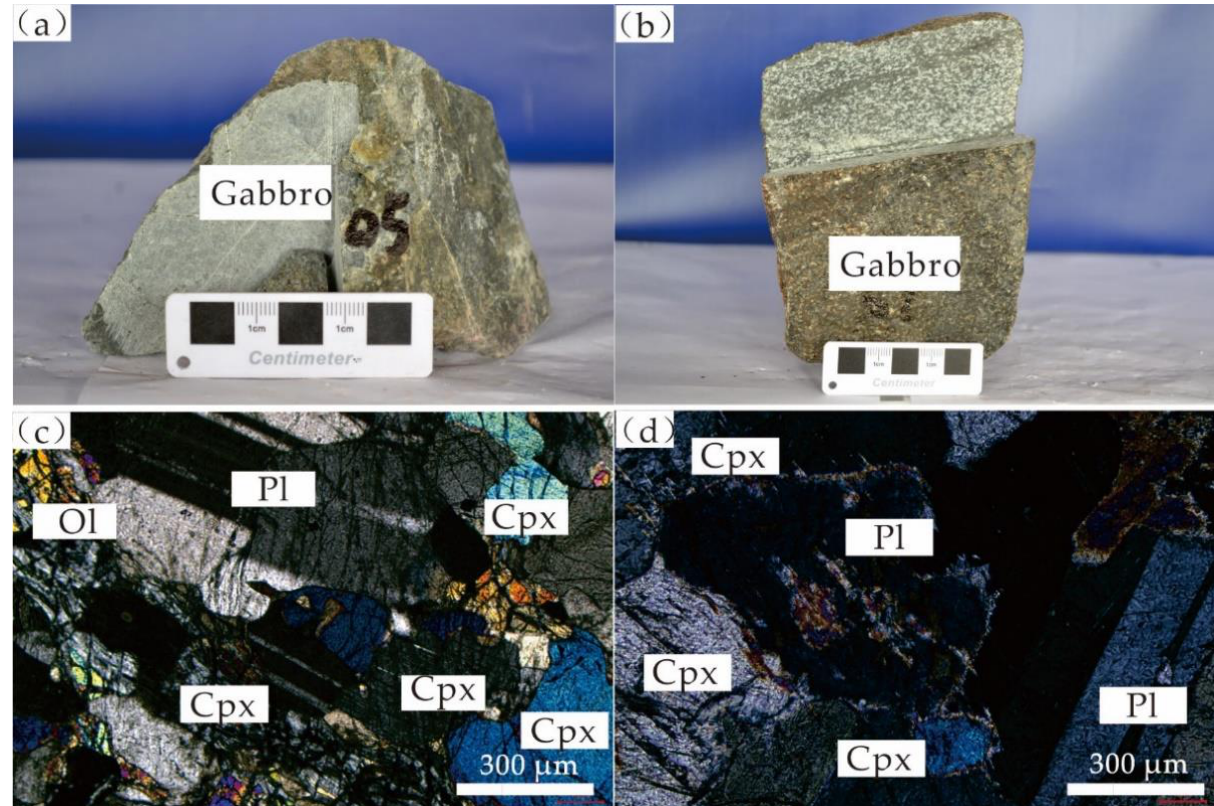
Figure 4. Photomicrographs of the Laguoco Gabbro. ( a,b ) The gabbro hand specimen; ( c,d ) Isotropic gabbro with gabbro and ophitic textures. Cpx: clinopyroxene; Ol: olivine; and Pl: plagioclase.